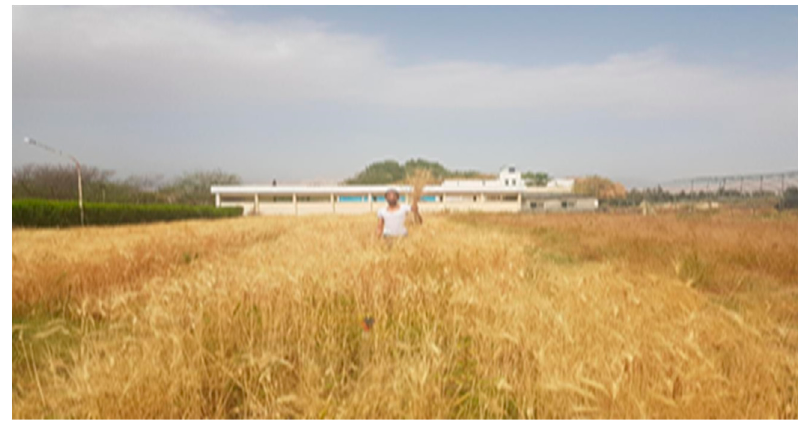
Figure 1 . Harvesting at field experiment in April 2018. Figure 1. Harvesting at field experiment in April